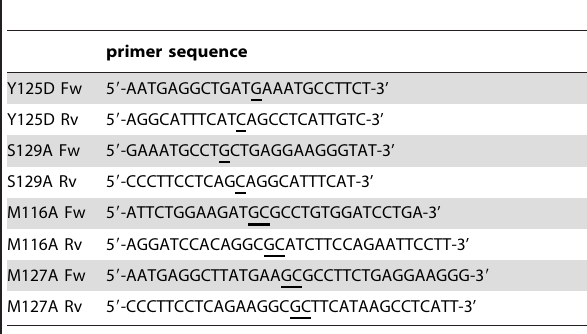
Table 1. The primer sets used in the site directed